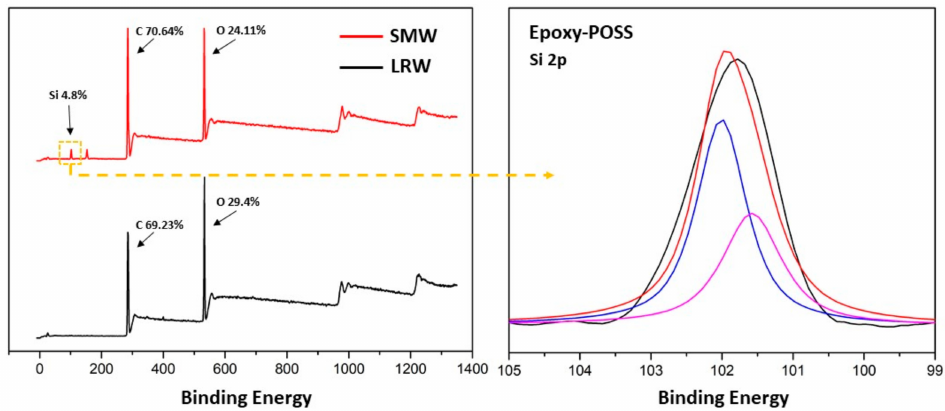
Figure 5. X-ray photoelectron spectroscopy scans of LRW and SMW.